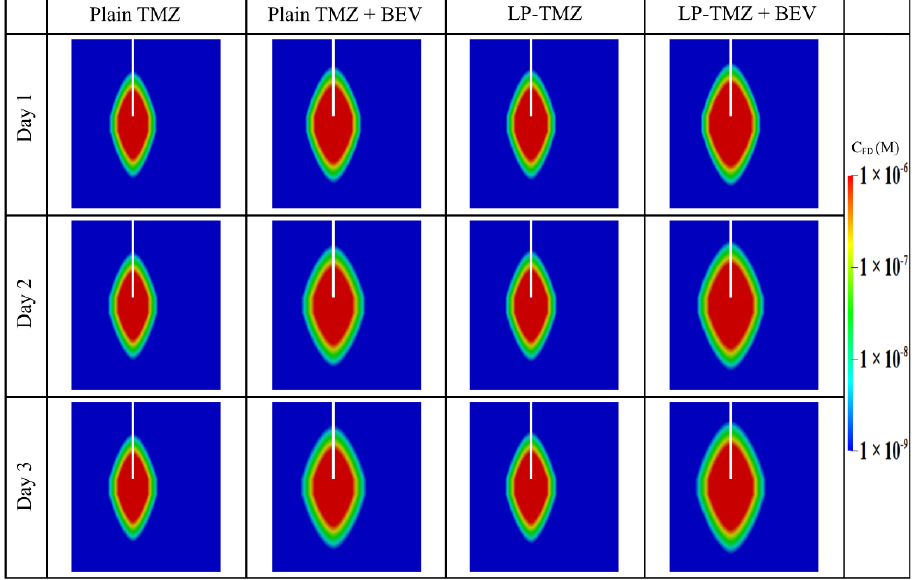
Figure A10. Spatial distribution of released free temozolomide at different time points.